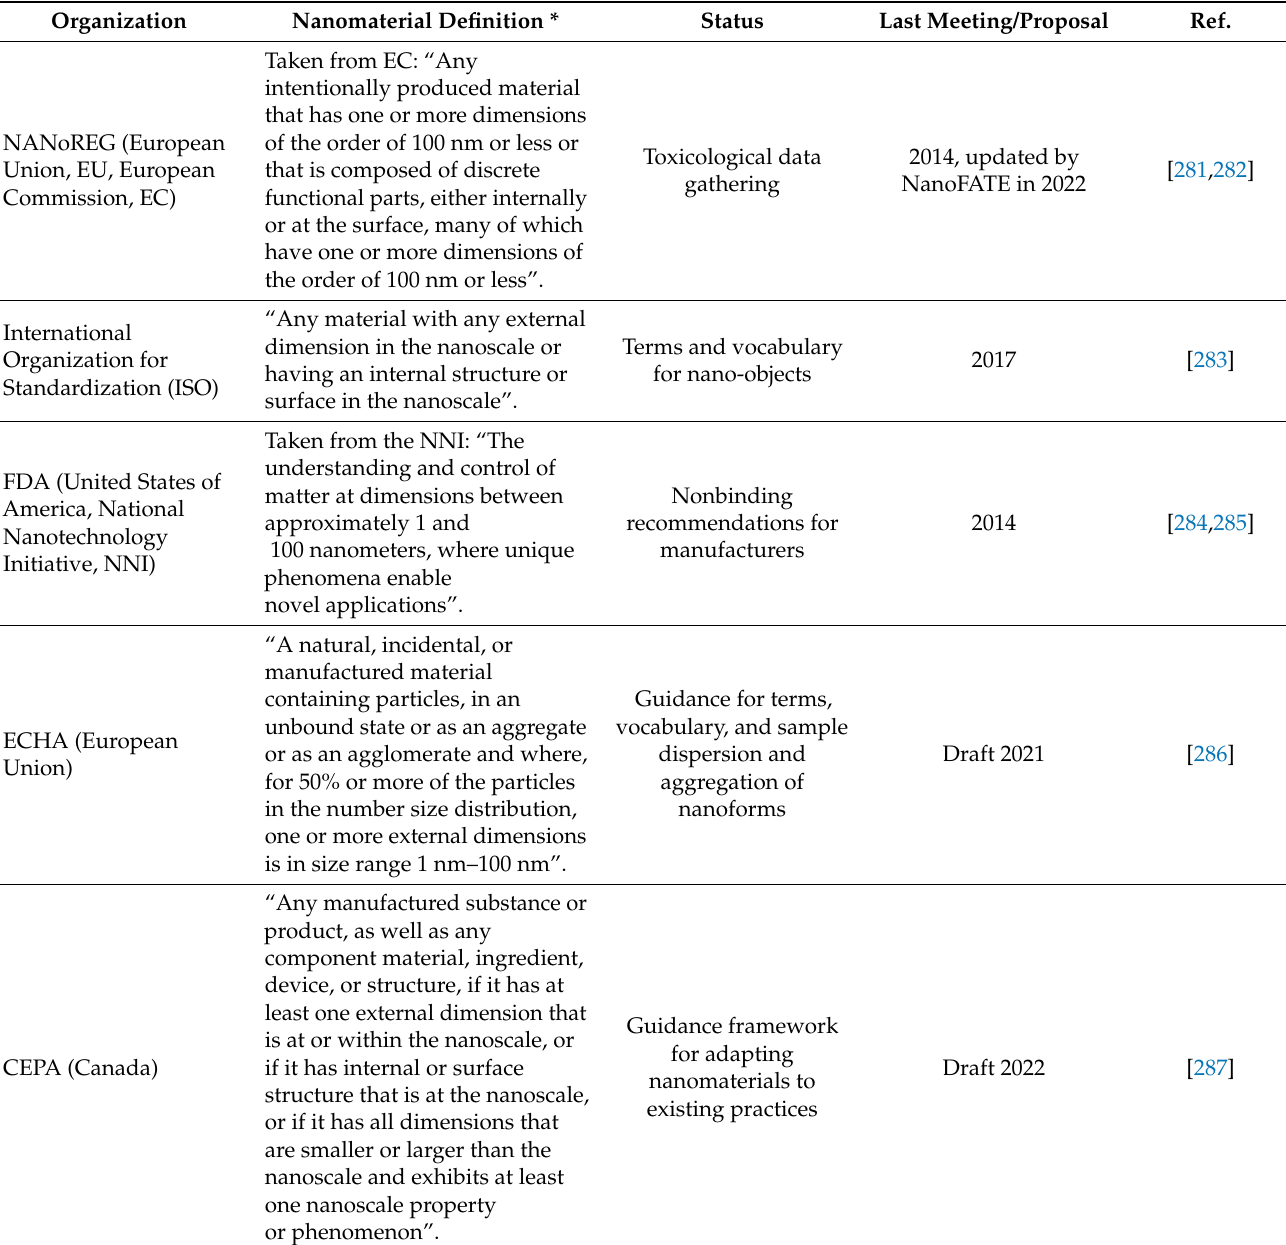
Table 4. Definitions of nanomaterials of different global